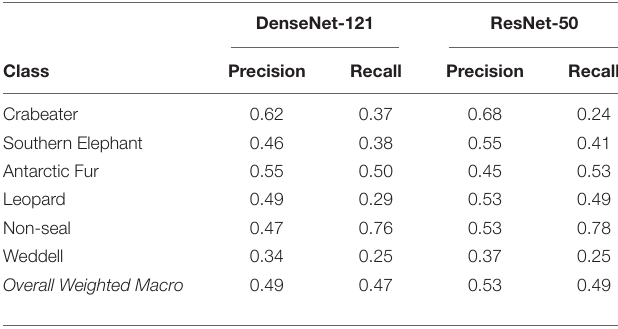
TABLE 1 | Precision and recall outcomes for different image classes from both CNN classifiers, and the overall weighted macro precision and recall for each model.